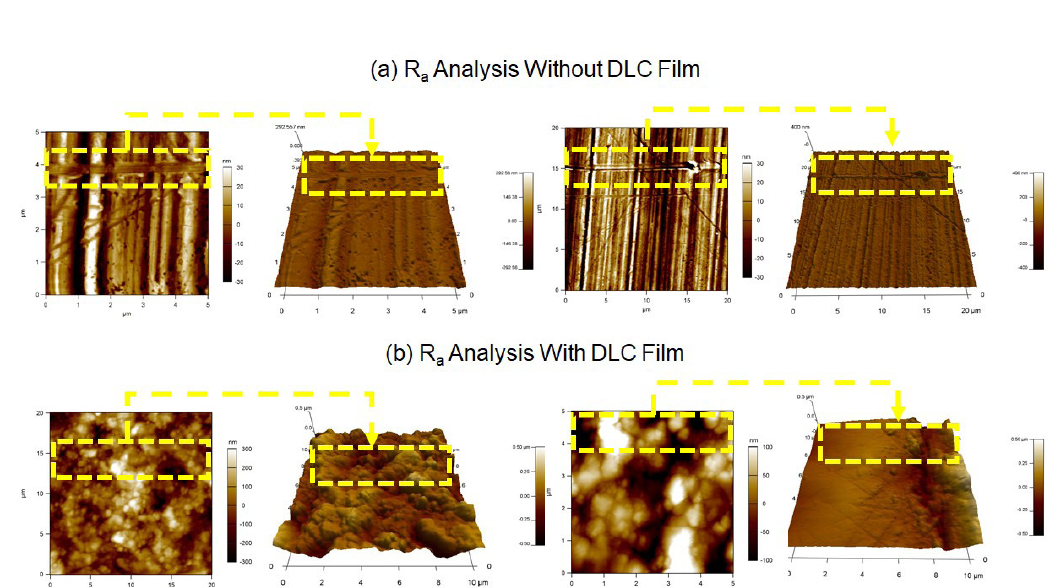
roughness assessment, before (a) and after (b) deposition of the DLC Figure 6. R a